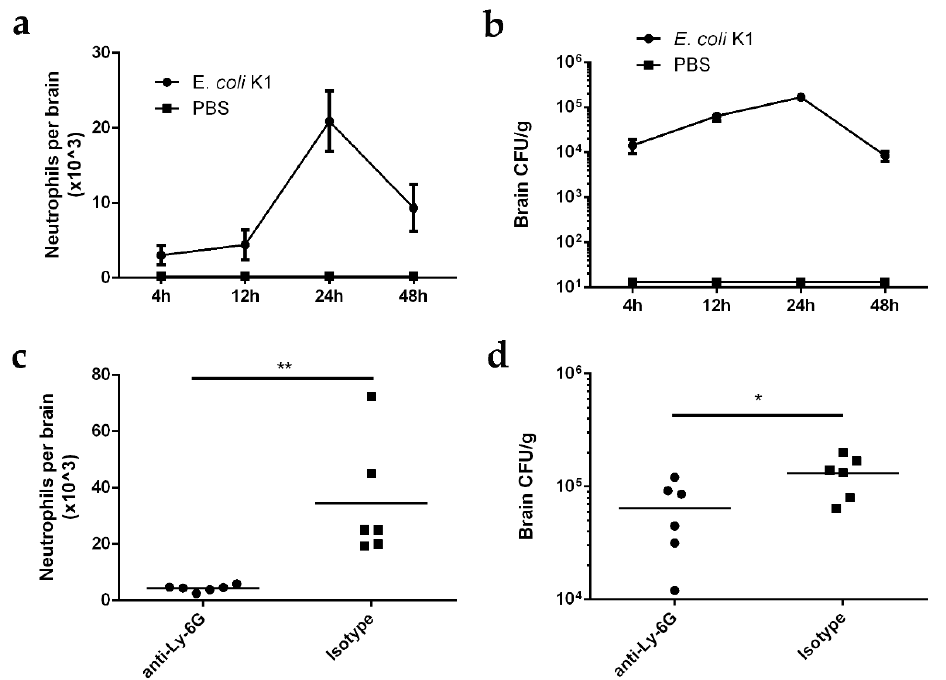
Figure 1. Escherichia coli K1 induces neutrophil recruitment into CNS of infected mice. ( a , b ) Neutrophil counts ( a ) and bacterial loads ( b ) in the mouse brain 4, 12, 24, and 48 h after intravenous injection with E. coli K1 or PBS. Data are presented as mean ± SD, n = 6 mice per group. ( c , d ) Neutrophil counts ( c ) and bacterial loads ( d ) in the Ly-6G-antibody-treated or isotype-treated (negative control) mouse brain 24 h after intravenous injection with E. coli K1. n = 6 mice per group. P values were determined using Mann–Whitney U test. * p < 0.05; ** p < 0.01.